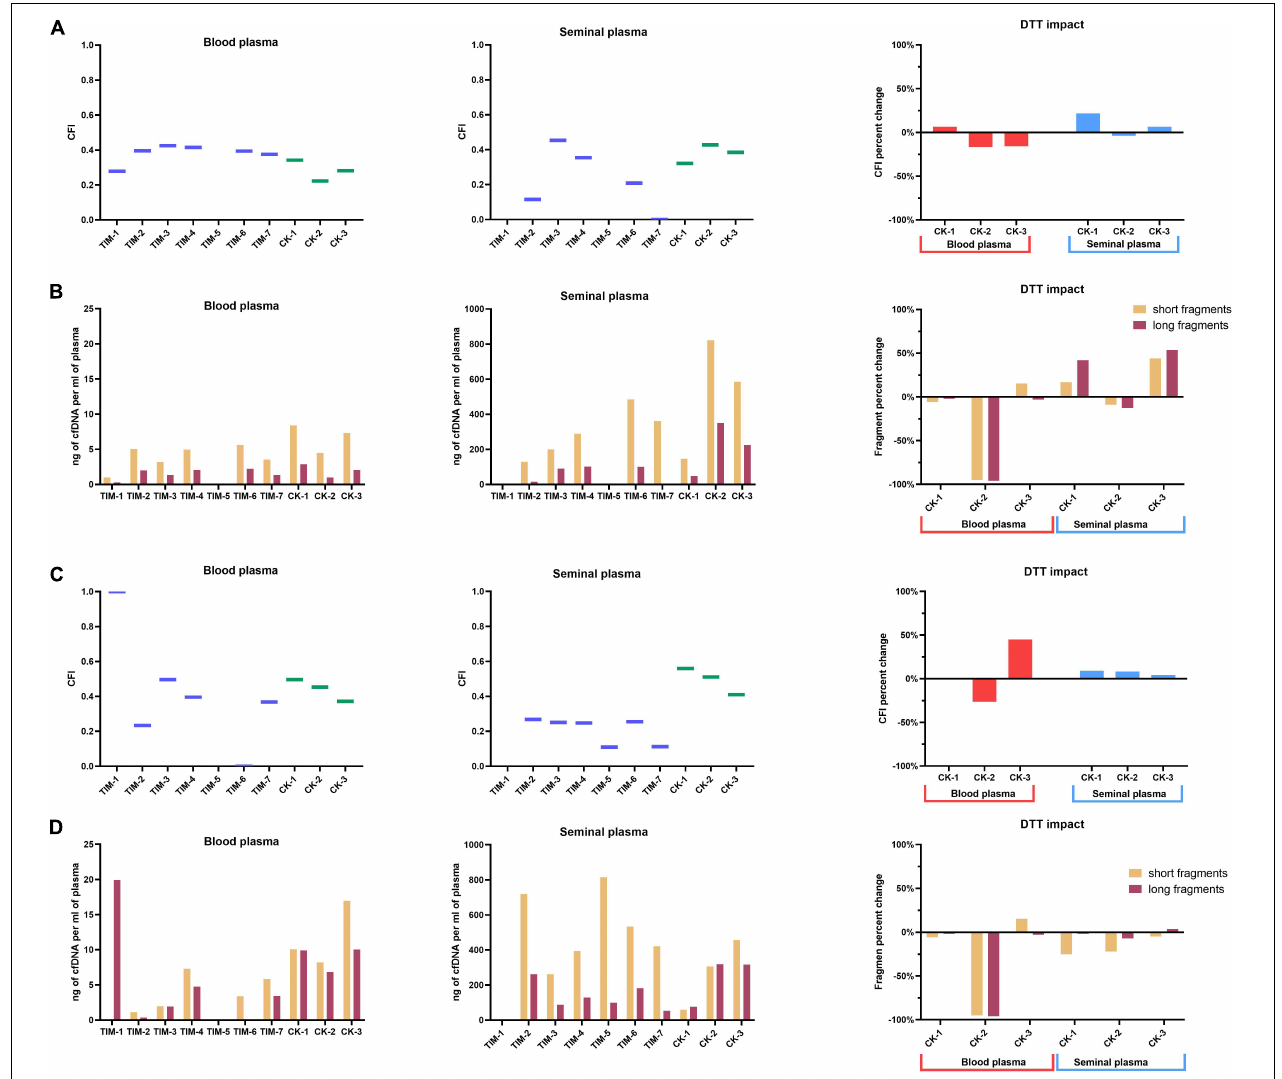
FIGURE 5 | Cell-free DNA fragmentation index. (A) CFI analysis by qPCR, with the impact of DDT on long fragment ratio; (B) total long and short LINE-1 cfDNA fragments quantified by qPCR, with the impact of DTT on total fragment yield; (C) CFI analysis by capillary electrophoresis, with the impact of DTT on long fragment ratio; (D) total long and short LINE-1 cfDNA fragments quantified by capillary electrophoresis, with the impact of DTT on total fragment yield. Values represented are